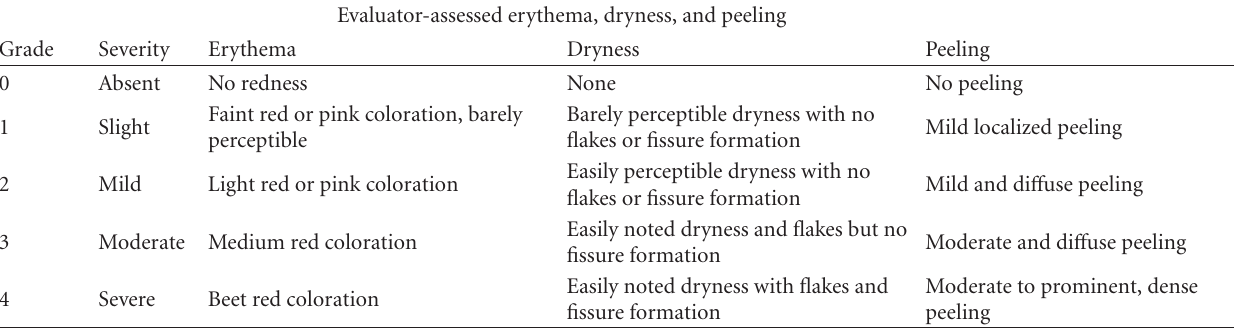
Table 4: Local tolerability assessments.